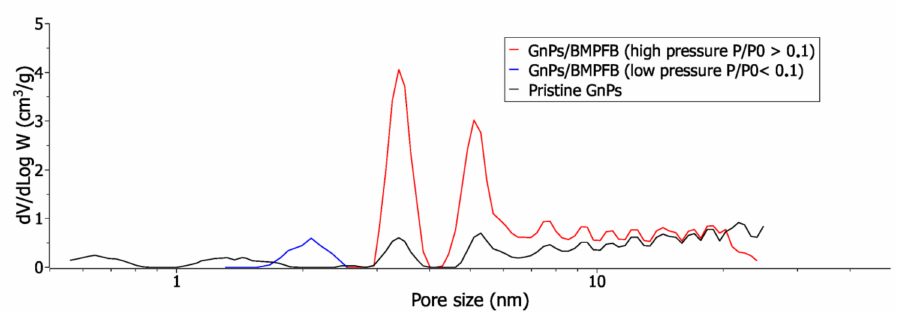
Figure 1. Nitrogen sorption isotherms of pristine graphene nanoplatelets (GnPs) (blue) and graphene nanoplatelets modified from solution (GnPs / BMPFB) (red) at 77 K.